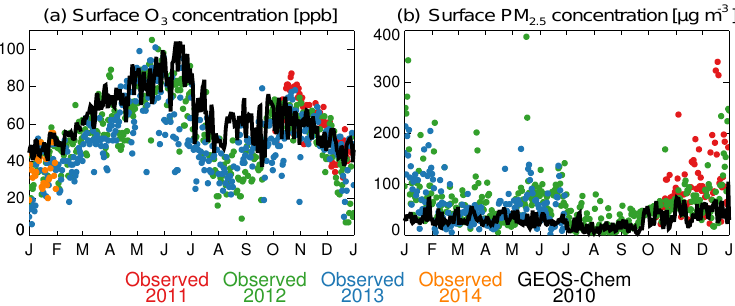
Figure 3. Daily surface (a) mean daytime (09:00–16:00 local time) ozone concentration and (b) mean daytime (12:00–16:00 local time) PM 2 . 5 concentration at Chandigarh, India. Observations in colored dots: 2011 (red), 2012 (green), 2013 (blue), and 2014 (orange). GEOS- Chem simulated values in black